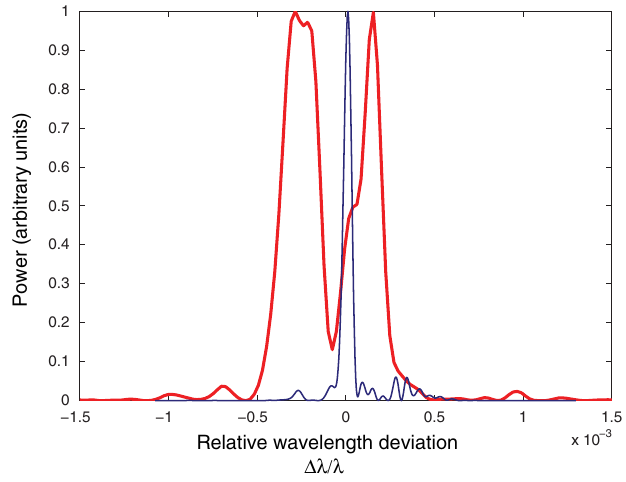
FIG. 12. (Color) Start-to-end, spectrum at saturation for the self- seeded scheme (blue line) and for the HGHG scheme (red thick line). FWHM bandwidths are respectively 5 (cid:2) 10 (cid:1) 5 and 5 : 8 (cid:2) 10 (cid:1) 4 . The results of the self-seeded scheme are averaged over 50 independent simulations. The saturation points are chosen to be, respectively, at z ¼ 20 : 5 m for the self-seeding and at z ¼ 11 m for the